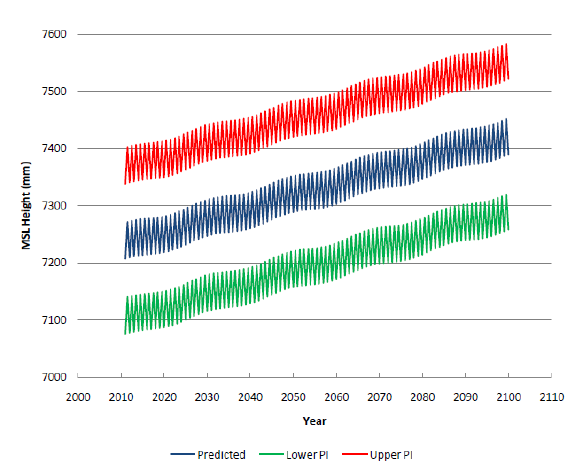
Figure 7. The predicted MSL heights (mm), plotted at 0.5 yr inter- vals, are referenced to the Fernandina vertical tide gauge reference level realized at 1975.5. The prediction interval (PI) is 95% confidence level. The estimated node tides